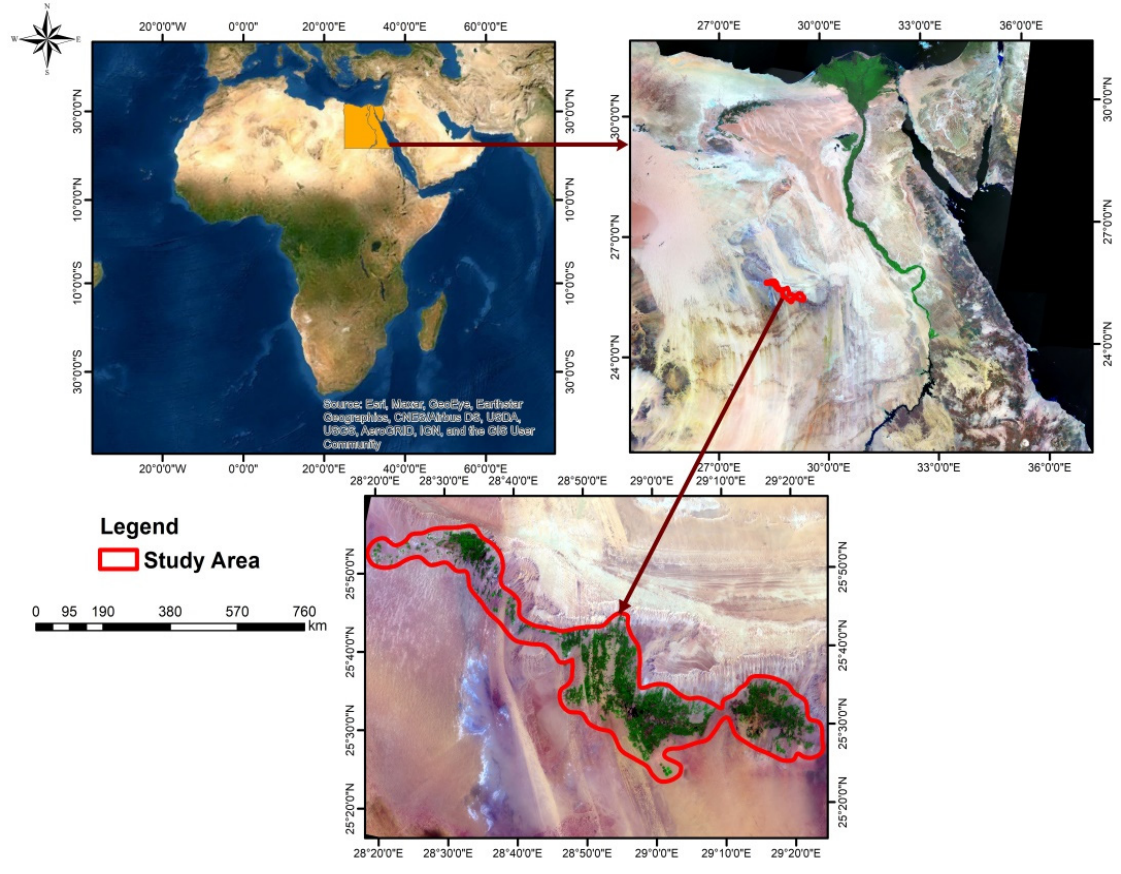
Figure 1. Location map of the study area relative to maps of Egypt (top right) and the Middle East and Africa (top left).